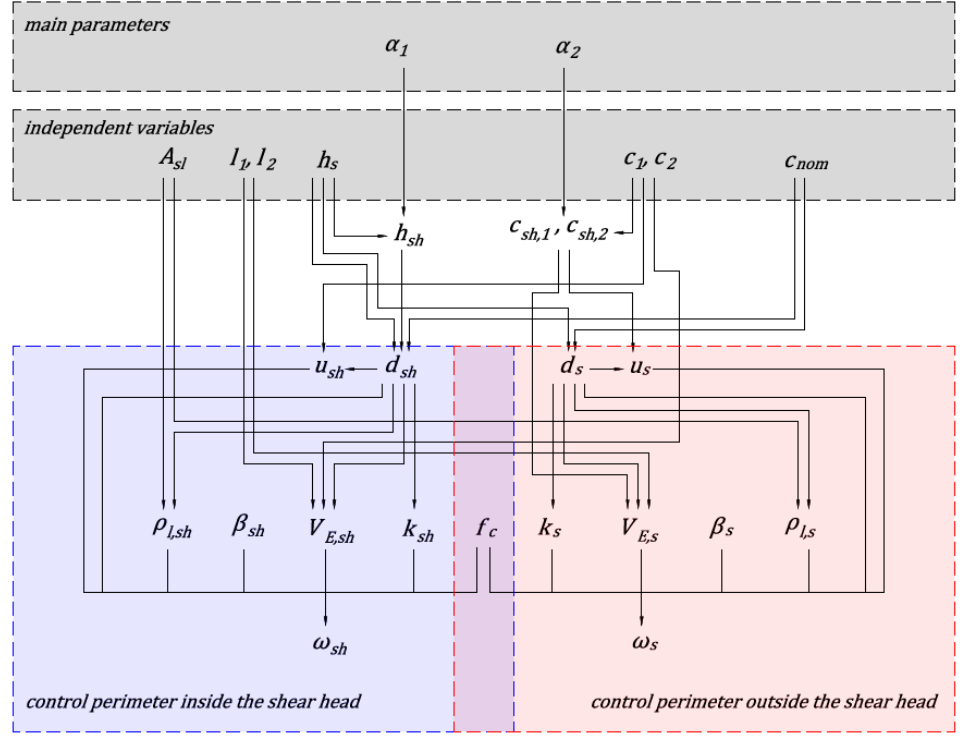
Figure 3. Parameters dependency diagram for the EC2 standard.